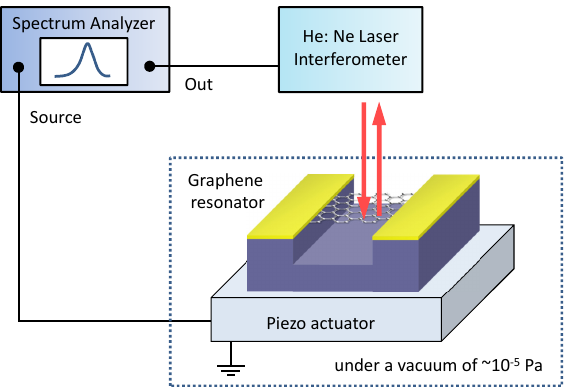
Figure 3. (Color online) A schematic of the detection setup of the mechanical vibration of the